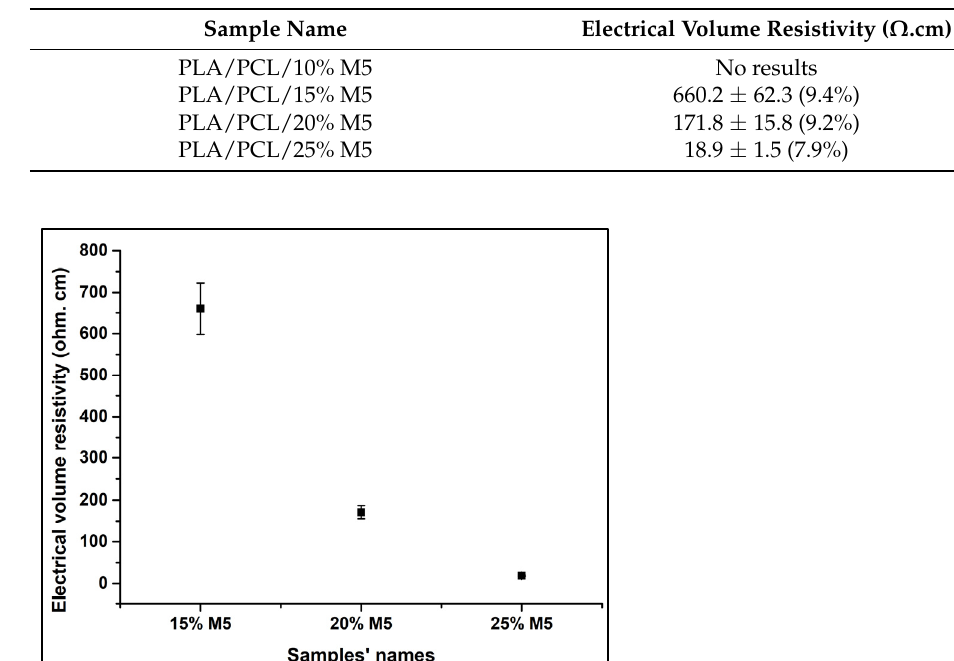
Figure 16. The electrical circuit connected using the 3D-printed PLA/PCL/25 wt.% M5 composite. The electrical volume resistivity results of the PLA/PCL/20 wt.% M5 composites printed according to the diagonal pattern (alternating raster angle of +45°/ − 45°) (Figure